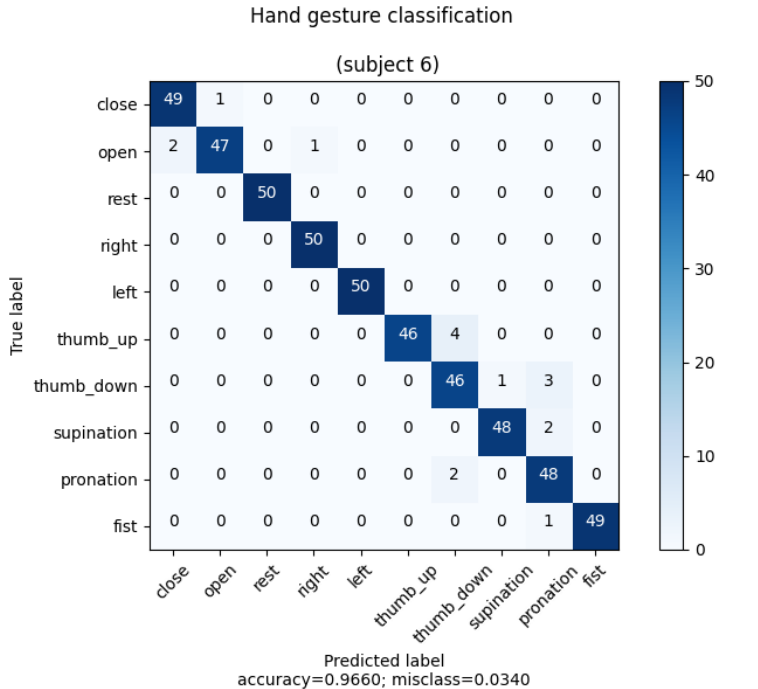
Figure A6. Confusion matrix of a subject who participated in data collection (subject